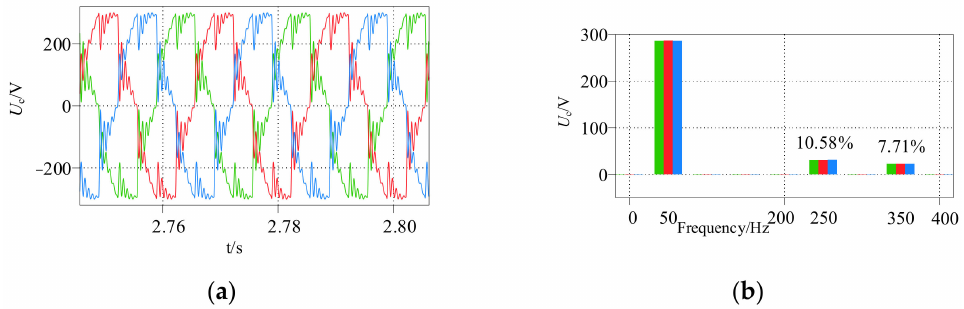
Figure 12. ( a ) Voltage of a GFM converter ( P set = 140,000 W, SCR = 29.04); ( b ) THD of a GFM converter ( P set = 140,000 W, SCR = 29.04). (Green for phase A, red for phase B, blue for phase